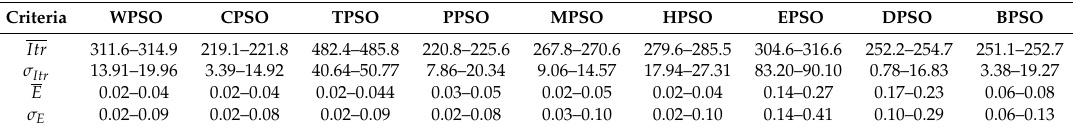
Table 4. Variation range of different N U and N A .